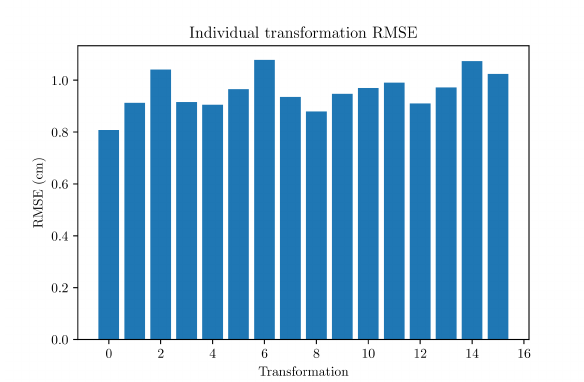
Figure 11: Individuals per vine stocks 3D registration RMSE. The final result of the alignment of the target dataset on the ref- erence data is shown in Figure 12-Bottom. On this dataset, we observed residuals after the alignment of less than 10cm, thus opening up the possibility of mapping at the level of each vine